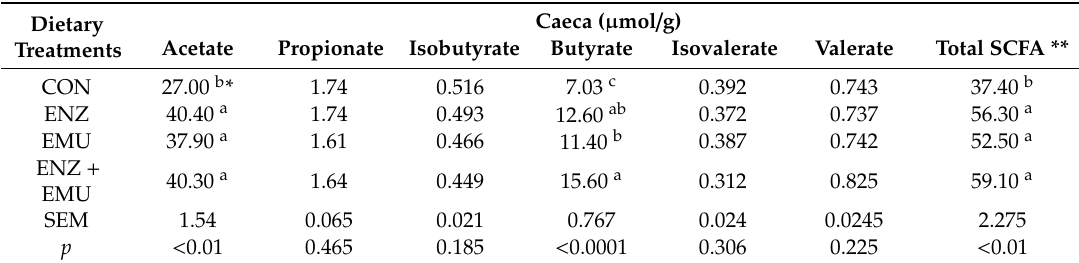
Table 7. Total short-chain fatty acid (SCFA) concentration in cecal digesta in birds fed control (CON), control supplemented with xylanase (XYL), control supplemented with an emulsifier (EMU), and control diet supplemented with xylanase and emulsifier XYL + EMU.